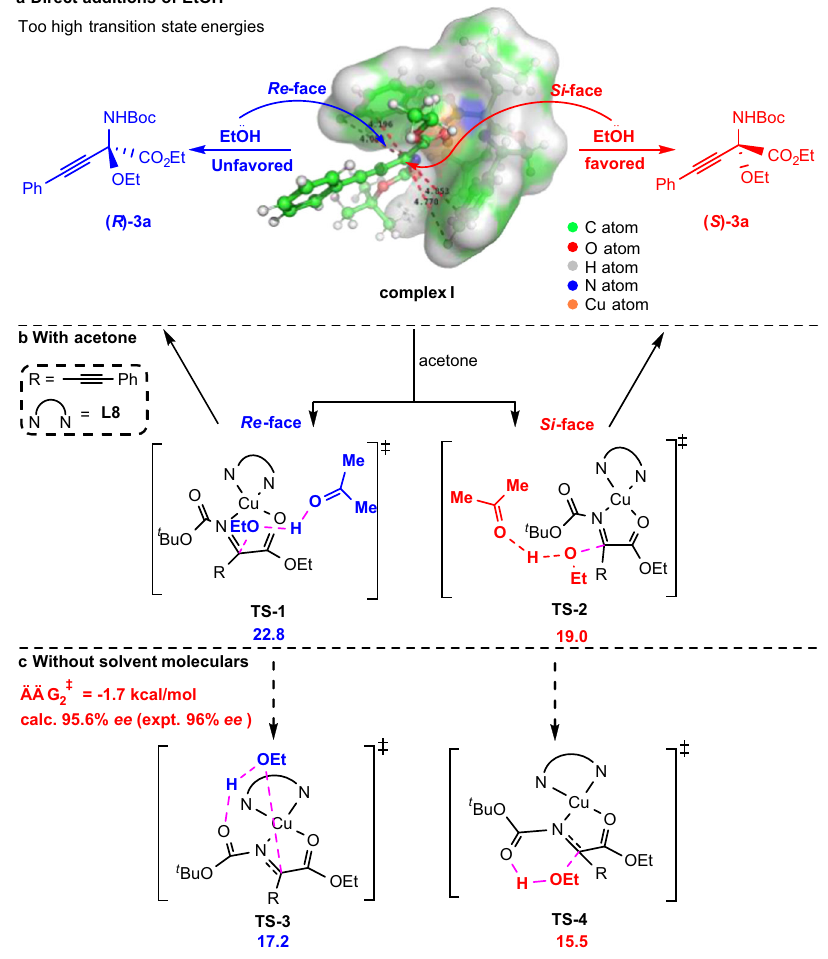
Fig. 5 Two possible competing pathways to form product 3a. a Direct additions of EtOH. b The transition states with acetone. c The transition states without solvent